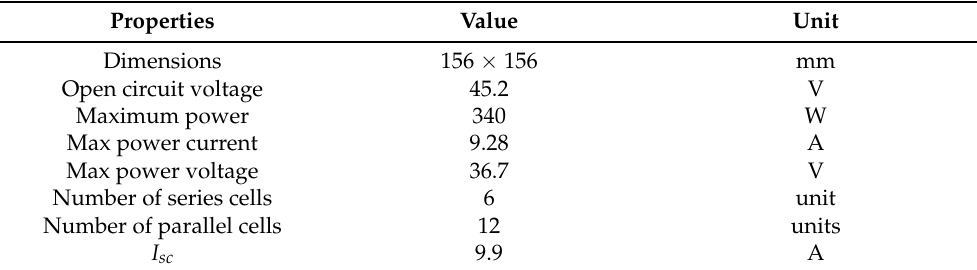
Table 2. Technical data of PEIMAR SG340P.